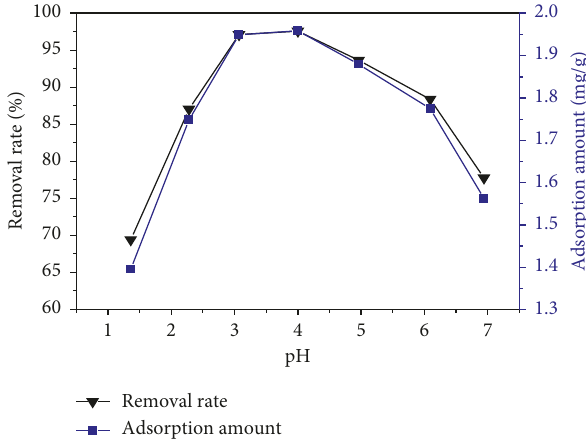
Figure 2: The effect of pH on adsorption of uranium(VI) by modified rice